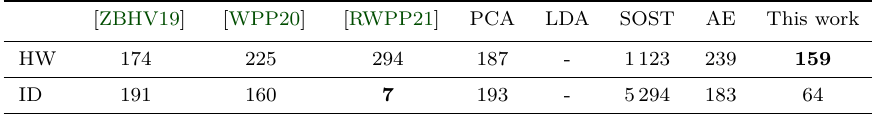
Table 3: Benchmark the attack performance ( T GE 0 ) with the ASCAD_F dataset.